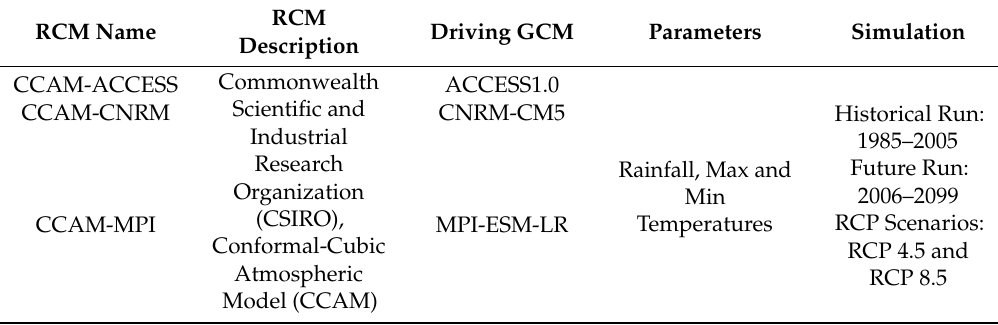
Table 3. Regional Climate Models used to develop climate